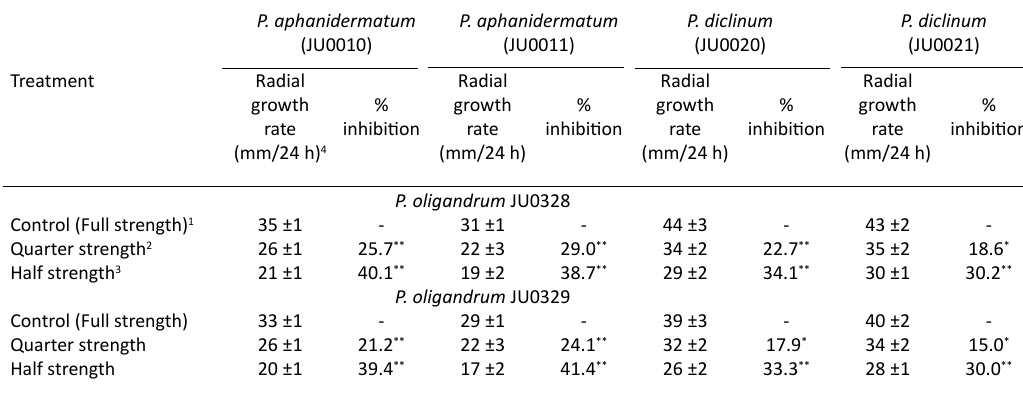
table 1. Effect of the inhibitory activity of different strength of cultural filtrate of two isolates of Pythium oligandrum on mycelial radial growth of two isolates of each of Pythium aphanidermatum and Pythium diclinum grown on solid V-8 agar medium at 25°C in the